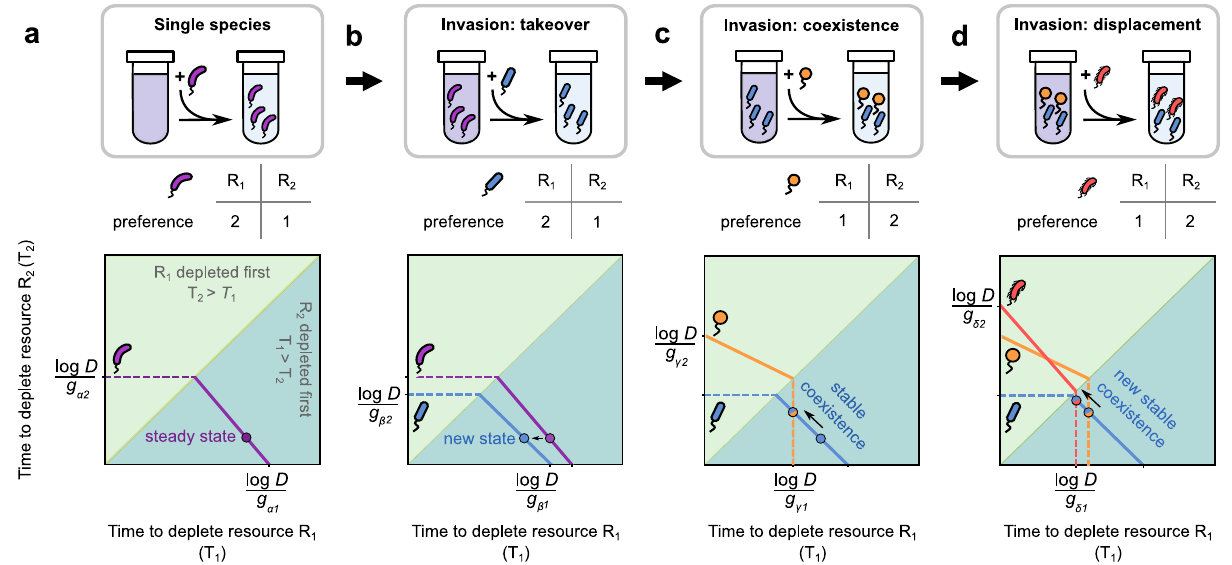
Fig. 4 A geometric approach for serially diluted communities explains how complementarity promotes diversity. Representation of stepwise community assembly in our geometric approach. a Resource utilization time plane for a single diauxic species (purple) growing on 2 resources, R 1 and R 2 . The x -axis represents the time taken to deplete R 1 , and the y -axis for R 2 . Each species is characterized by a zero net growth isocline (ZNGI) comprising two line segments: a dashed line indicates the less preferred resource, while the solid line indicates the more preferred resource (the table shows preferences). In monoculture, the steady state can only occur on the solid line, here the bold circle. The T 1 = T 2 line separates the plane into two triangular regions: in the light green region, R 1 is depleted fi rst, while in the dark green, R 2 is. b Representation of a new species invasion, where the invader (blue) takes over and displaces the purple resident. The invader has the same resource preferences as the resident, but its ZNGI is closer to the origin, suggesting that it depletes resources faster. The new steady state is shown as a bold blue circle. c Representation of a new species invasion, where the invader (orange) coexists with the new resident (blue). The invader has complementary preferences to the resident, indicated by the solid segment of its ZNGI in the light green region. Both species stably coexist (see Supplementary Text, sections A and B) at the intersection of their ZNGIs (orange/blue circle). d Representation of a new species invasion, where the invader (red) displaces only one of the residents, that with the same top choice resource (orange). The invader (red) and the resident (blue) coexist stably at the intersection of their ZNGIs (red/blue bold point). In all cases, the point marking the steady state moves closer to the T 1 = T 2 line, showing that the depletion times for both resources become similar to each